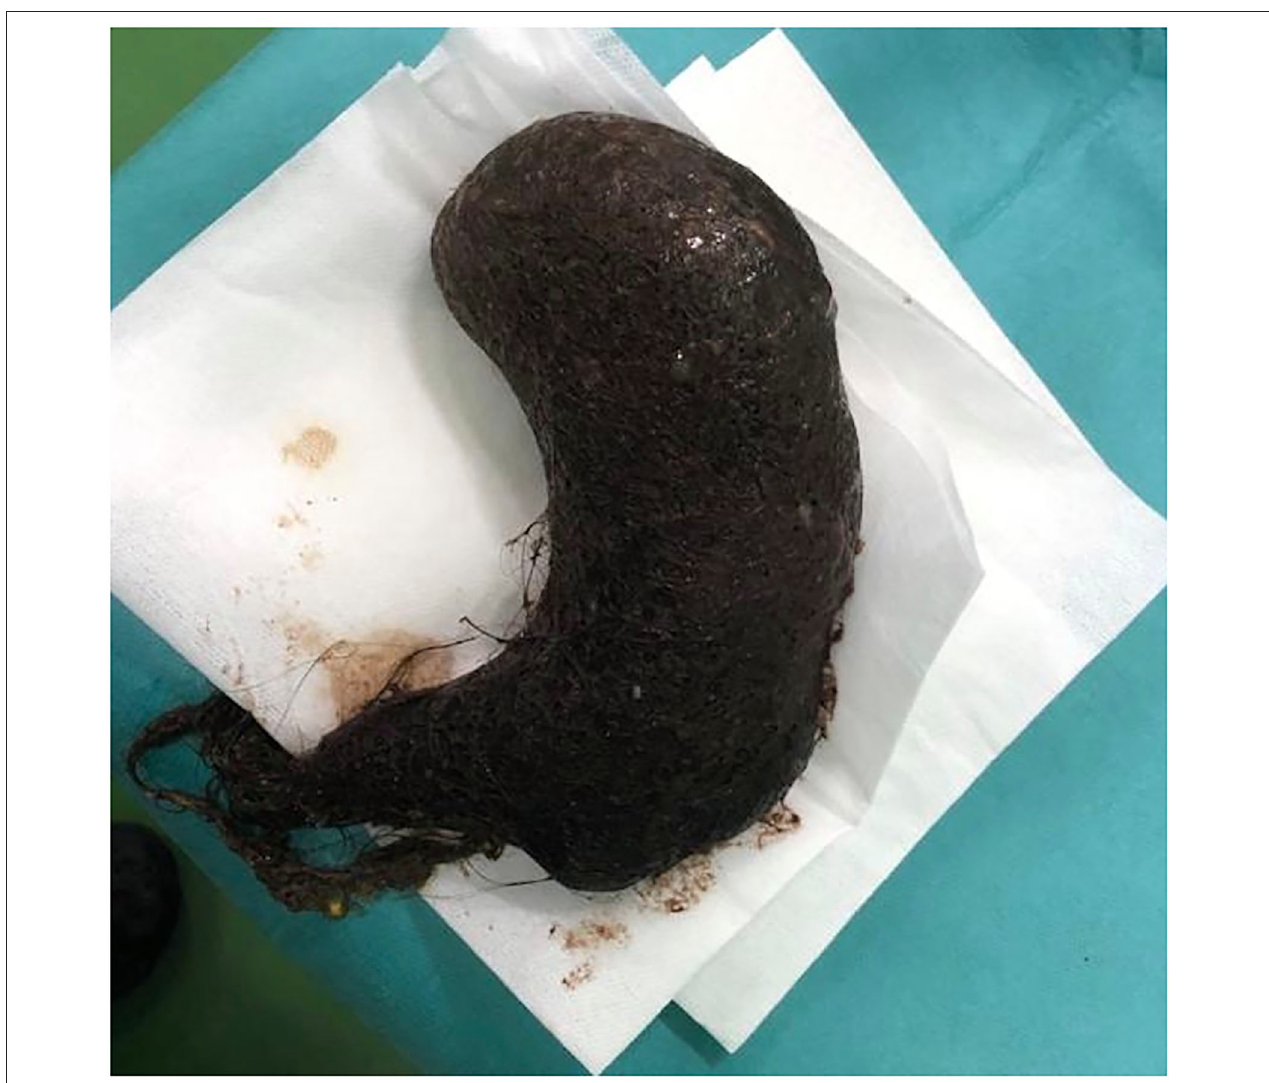
FIGURE 4 | Macroscopic aspect of hole